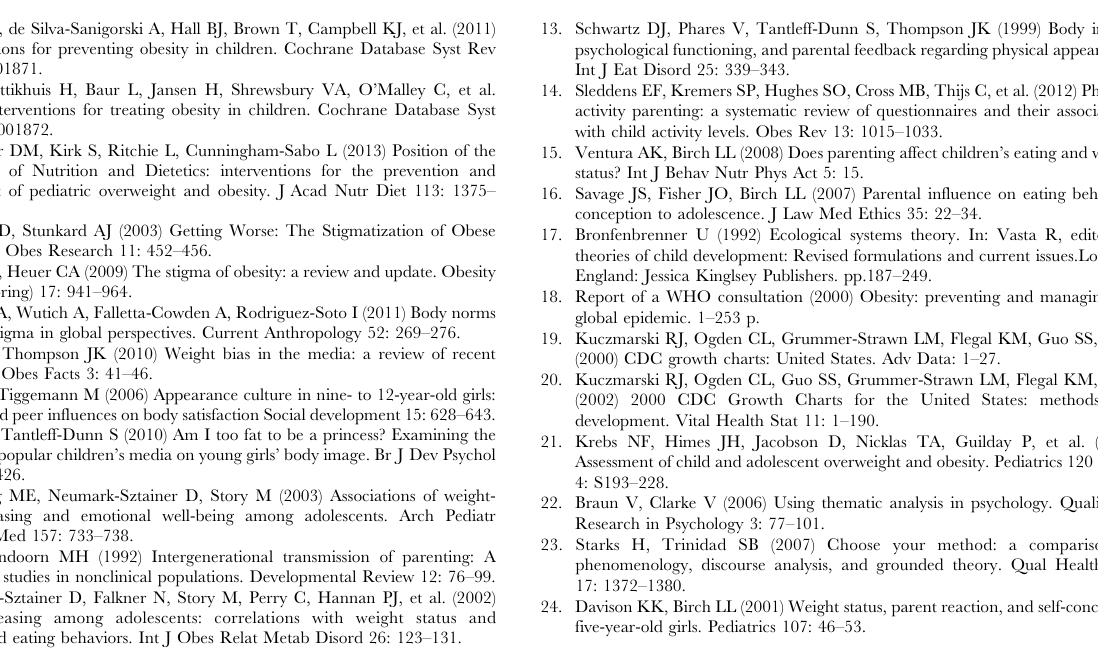
Table S1 Awareness of body weight in childhood emerged through comments from parents or peers. Table S2 Awareness of body weight in childhood emerged through comparisons with peers. Table S3 Awareness of body weight in childhood emerged through negative feelings about one’s own body size. Table S4 Awareness of body weight in childhood was associated with negative feelings or experiences. Table S5 Childhood experiences of comments on body weight directly influenced participants’ approaches to discussing their preschoolers’ body